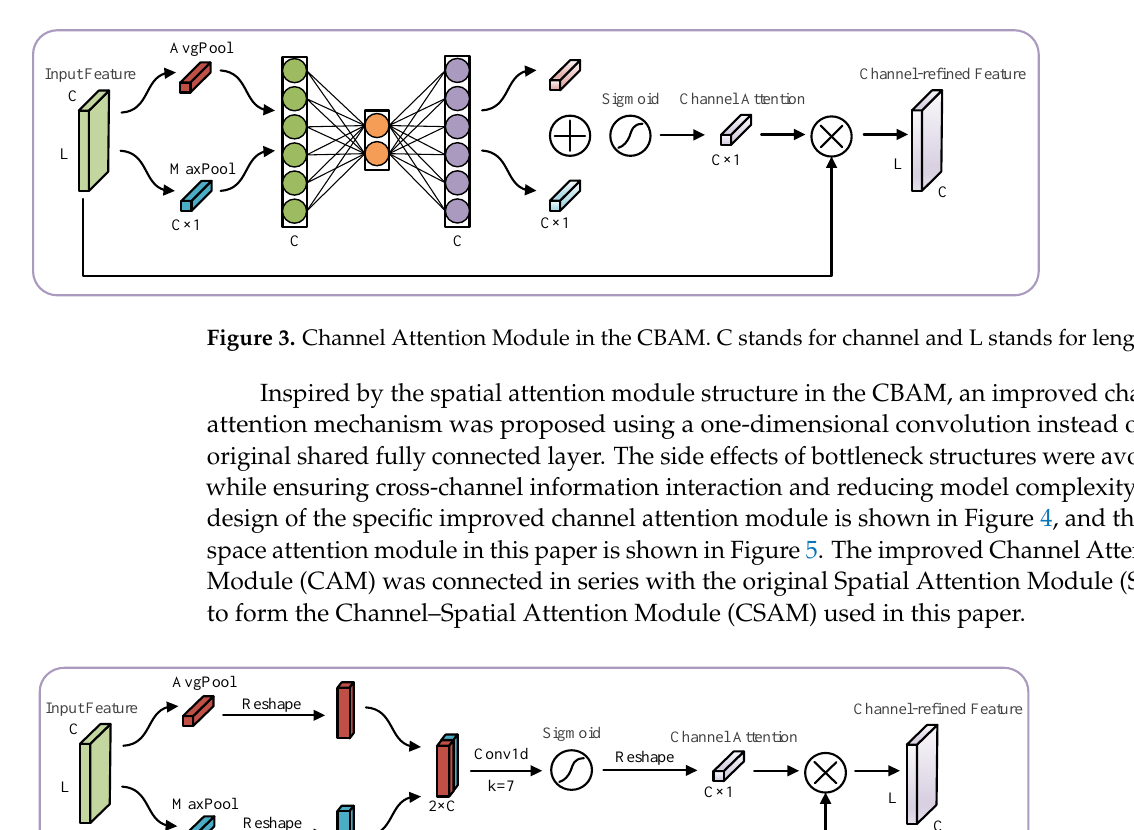
7 of 24 single channel or spatial attention module. The channel attention module in the CBAM is shown in Figure 3. First, the spatial information in the average pooling and maximum pooling aggregated feature maps was used. Then, two sets of channel attention weights were obtained through a shared fully connected layer, and the two sets of weights were combined. Finally, the final channel attention weights were received after the Sigmoid function. Although channel attention implements interactions between channels using a shared fully connected layer, the dimensionality reduction due to its bottleneck structure has side effects on channel attention prediction. It is not efficient or necessary to capture the interactions between all channels [31]. Channel Attention